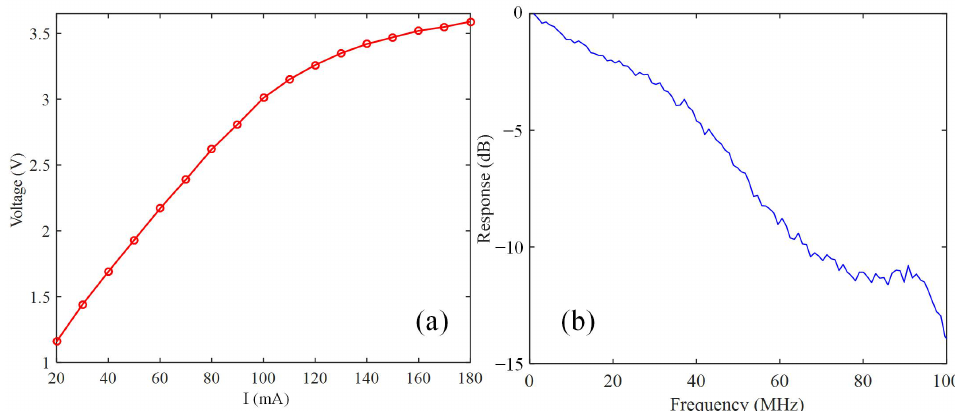
Figure 5. Measured ( a ) nonlinear voltage–current curve and ( b ) low-pass frequency response of the